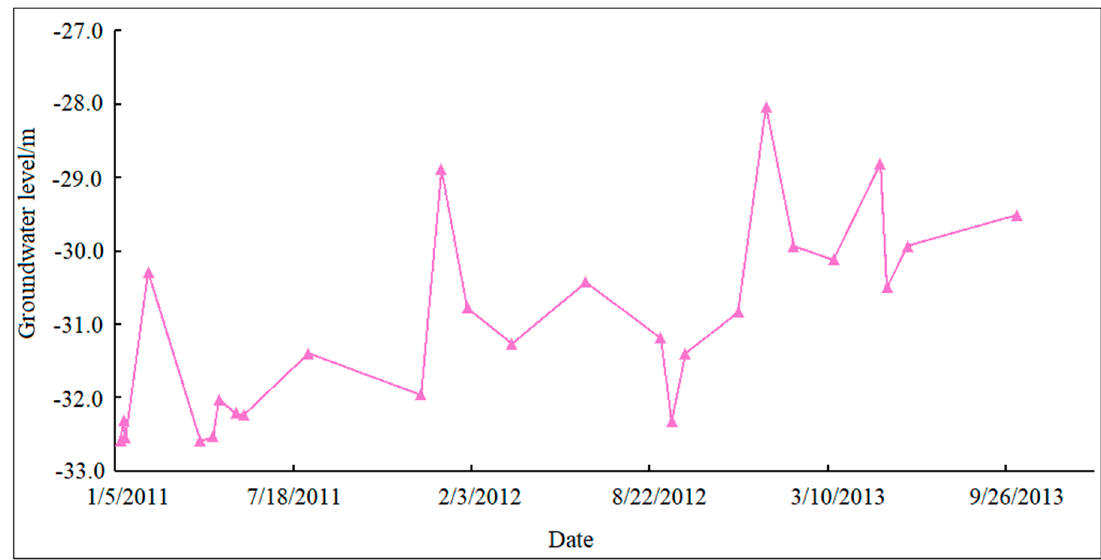
Figure 5. Dynamic variation of groundwater level in the second confined aquifer.